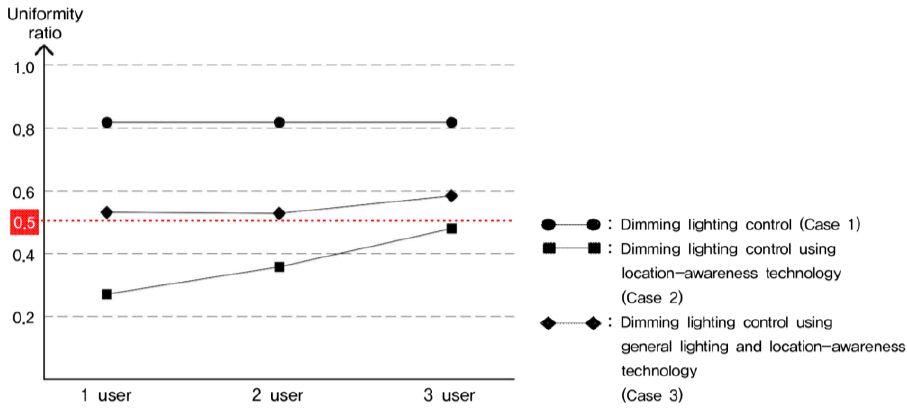
Figure 7. Average uniformity ratio according to the lighting control method.